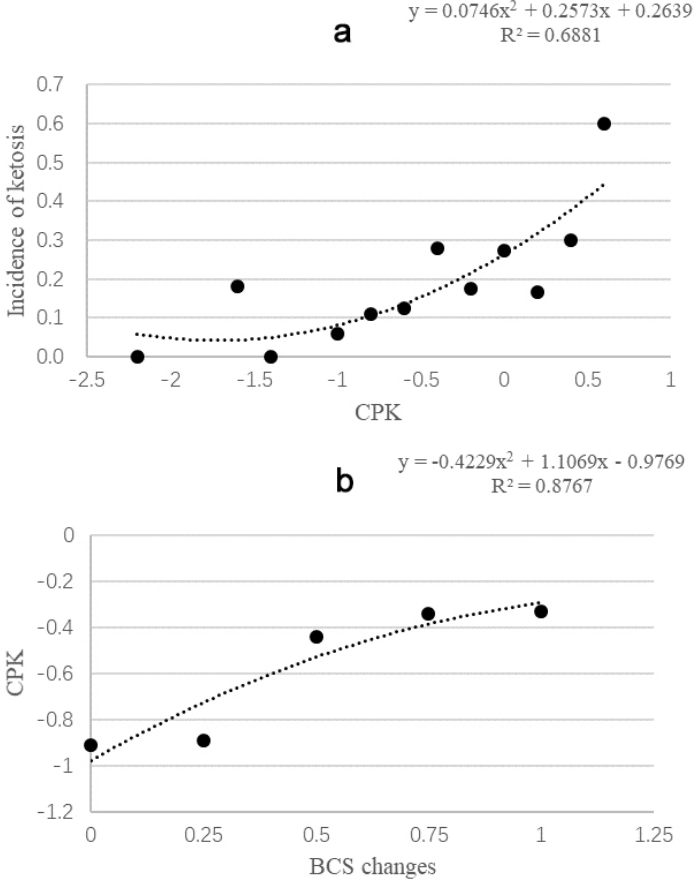
Figure 1. The scatter plot of CPK and BSC changes. ( a ) the model of correlation between capability index (CPK) and the incidence of postpartum ketosis, the risk of ketosis increased with an increase in CPK; ( b ) the model of correlation between CPK and BCS changes, the case where the BCS change is less than 1. When the BCS change is greater than 1, it is considered a system error.